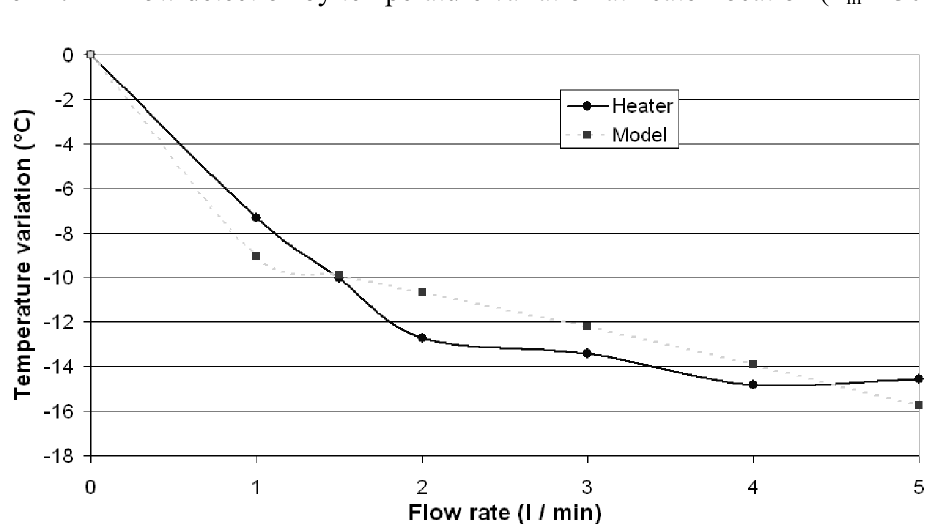
Figure 12. Air flow detection by temperature variation at heater location (P